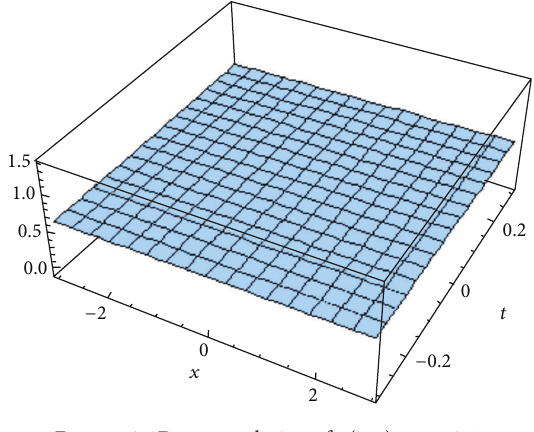
Figure 6: 3D, exact solution of 𝜇(𝑥,𝑡) at 𝑡 = 0.1 .